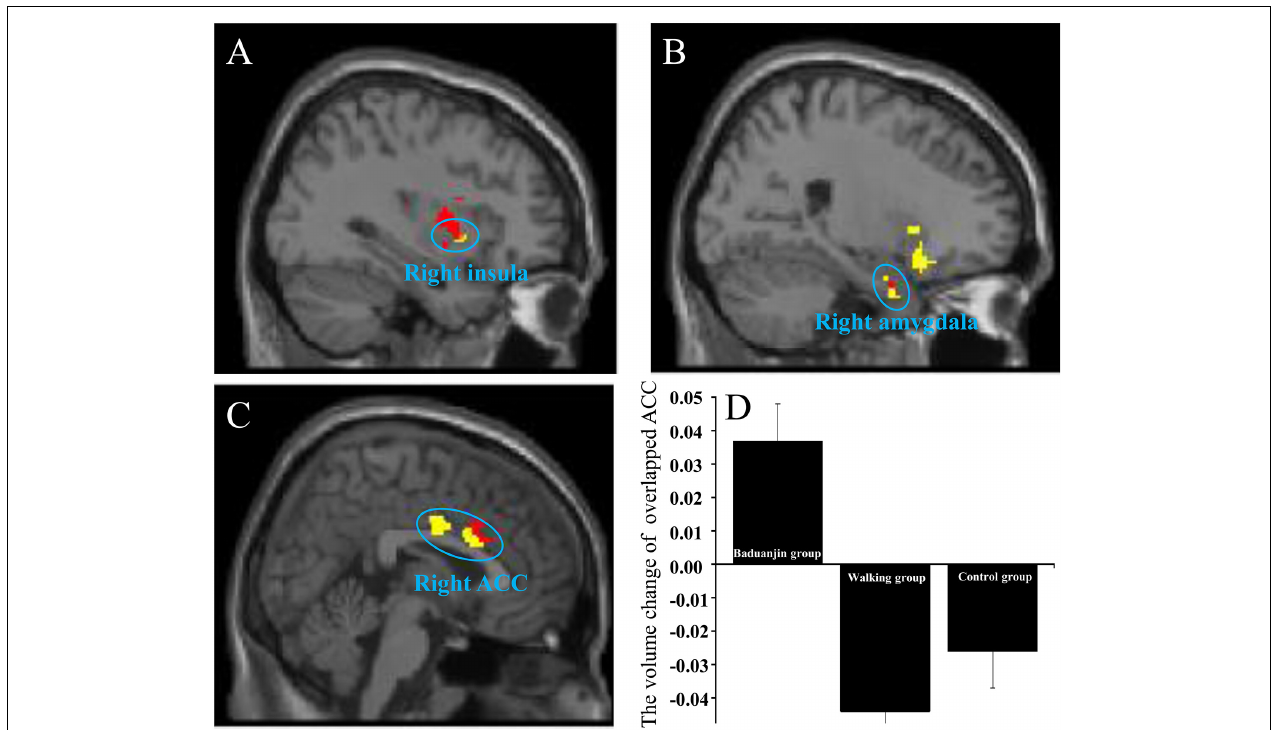
FIGURE 2 | The increased overlapping rsFC in the Baduanjin group between the right LC and left VTA compared to the control group/walking group and the VBM analysis of the overlapping brain region. (A) the overlapping brain region in the right insula; (B) the overlapping brain region in the right amygdala; (C) the overlapping brain region in the right ACC; Red, using the right LC as the seed; yellow, using the left VTA as the seed; (D) the ROI VBM analysis in the right ACC among the three